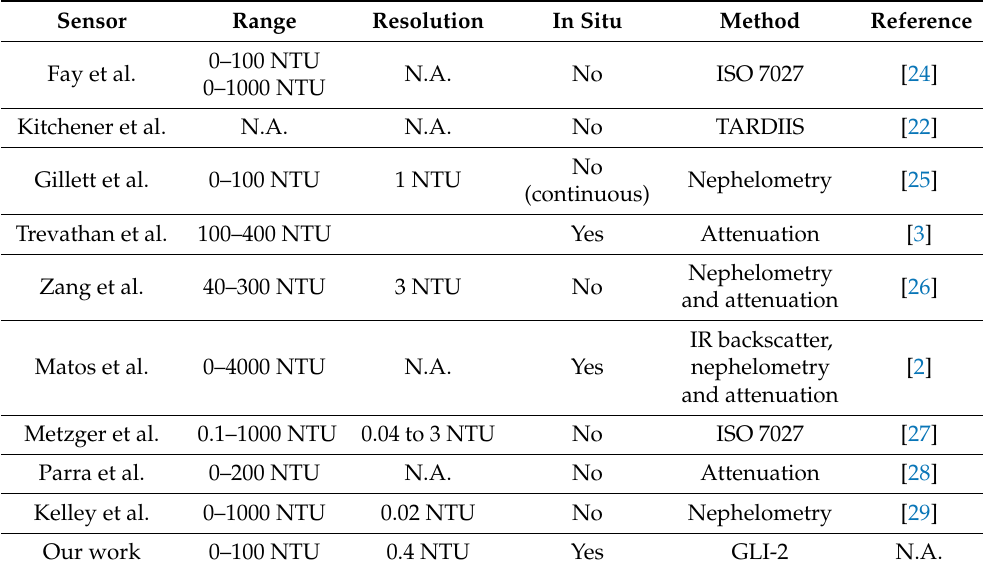
Table 1. Recent achievements in the literature on turbidimeter